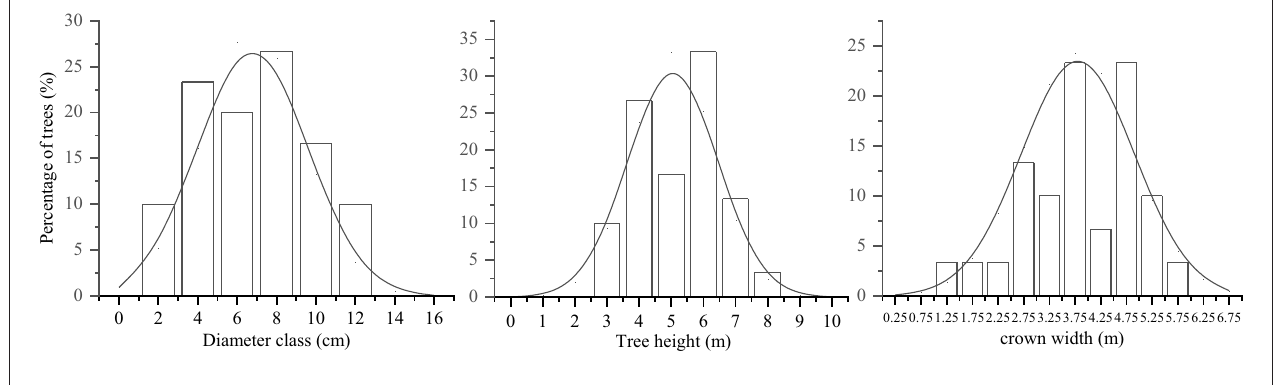
FIGURE 1 | Distribution characteristics of Sapindus mukorossi trees with plant size